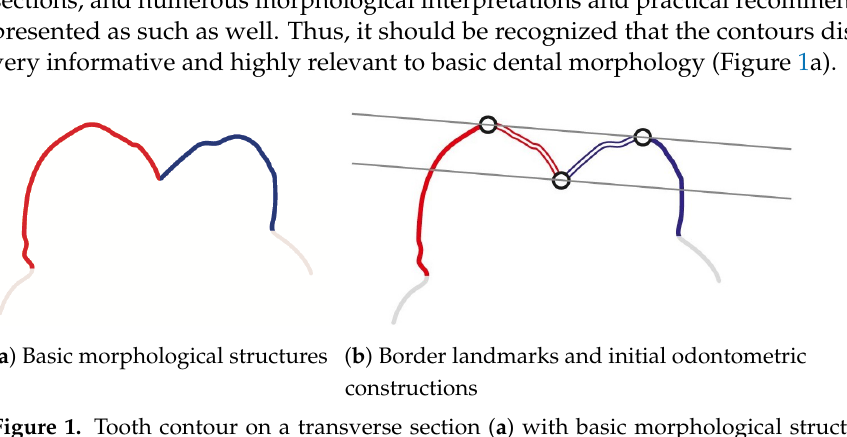
Figure 1. Tooth contour on a transverse section ( a ) with basic morphological structures, border landmarks and initial odontometric constructions ( b